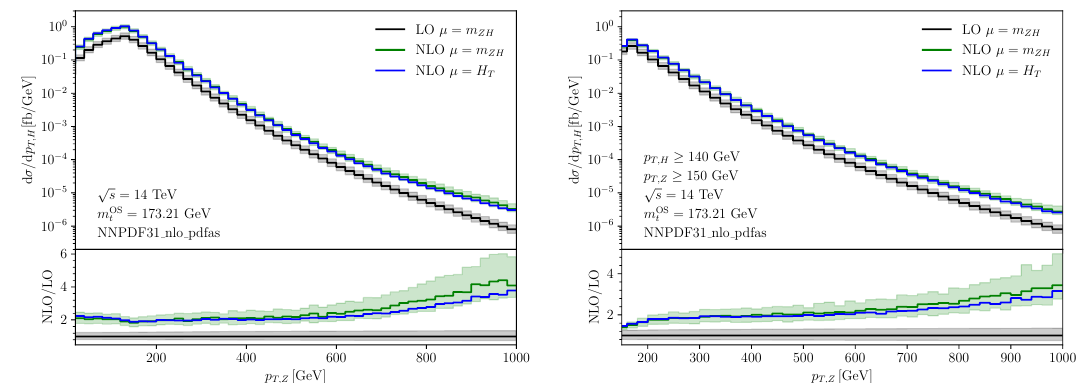
Figure 6. Distribution of the Z -boson transverse momenta at LO and NLO, including scale uncertainties resulting from a 7-point scale variation around the central scale µ = µ m ZH . We also show NLO predictions for µ = H T . Left: fully inclusive, right: results based on p T,H ≥ 140 GeV, p T,Z ≥ 150 GeV.